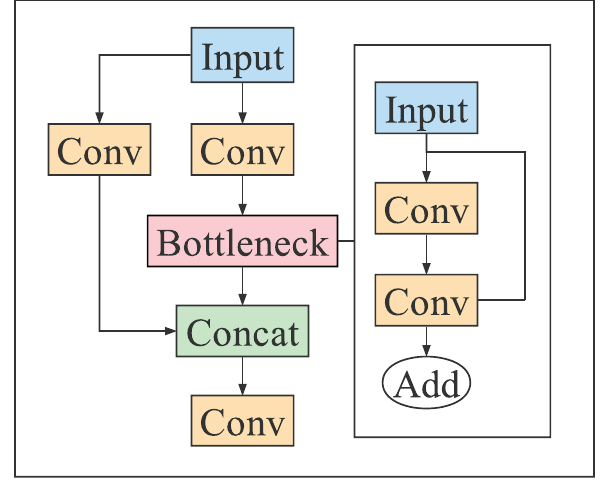
Figure 3. C3 structure.